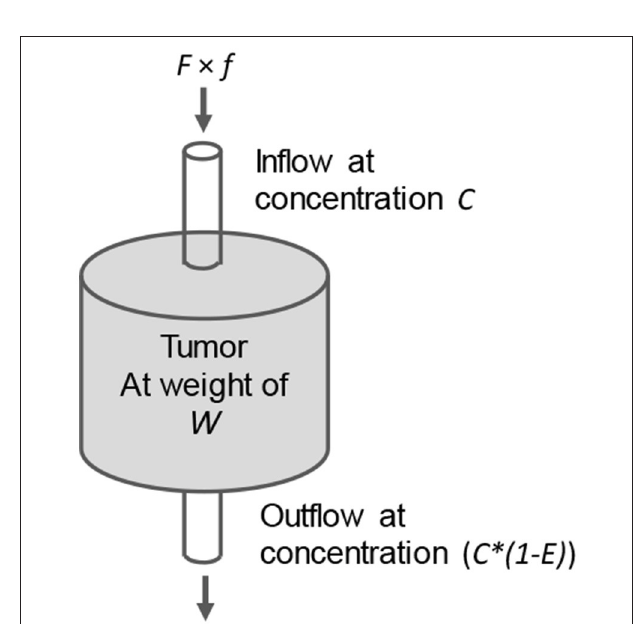
FIGURE 4 | The “chemical reactor” model showing the inflow and outflow of a targeting molecule in the tumor (like a chemical reactor). E is the